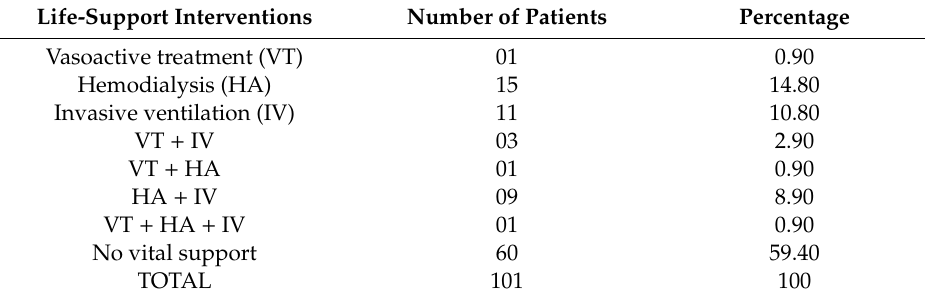
Table 3. Life-support techniques used in hospitalized patients with severe malaria.